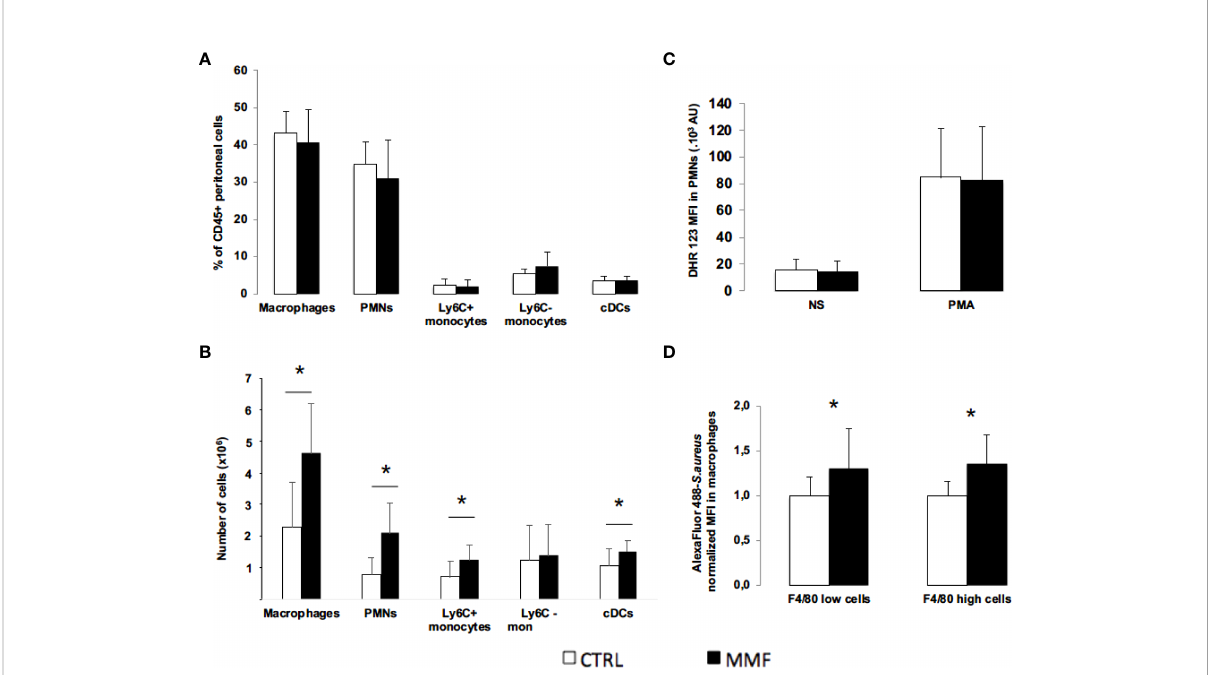
FIGURE 5 Effect of MMF on innate immune cells distribution and functions during S. aureus sepsis Mice were treated with MMF (n=10, black histogram), or with the same volume of NaCl 0.9% (control mice, n=10, white histogram). 24 hours after infection, peritoneal and splenic cells were stained for CD45, CD11b, Ly6C and Ly6G (PMNs), CD11b and Ly6C (monocytes), CD11b and F4/80 (macrophages) and CD11c (conventional dendritic cells) (A, B) . Mice were treated with MMF (black histogram, n=14) or the same volume of NaCl 0.9% (white histogram, n=14) and were infected with S. aureus one hour after the 2 nd injection. Peritoneal cells were collected 16 hours after infection, incubated with DHR 123 and cells were then activated in vitro by PMA (0.2 m g). NS represents non-stimulated condition. Peritoneal cells were stained for the PMN markers and DHR 123 fl uorescence was measured by fl ow cytometry (C) . Peritoneal cells (6. 10 5 cells) were isolated from mice treated with MMF (black histogram) or NaCl 0.9% (white histogram) for 4 days, and were incubated 30 minutes with S. aureus (MOI 10) stained with Alexa Fluor 488. Cells were then stained with F4/80, and intracellular MFI was measured by fl ow cytometry in F4/80+ macrophages and F4/80 high macrophages. MFI for each condition was normalized on the average of MFI in control mice for each experiment. Data were representative of 6 experiments (D) . Data are represented as means ± SD. Differences were calculated using Student ’ s t test. * P